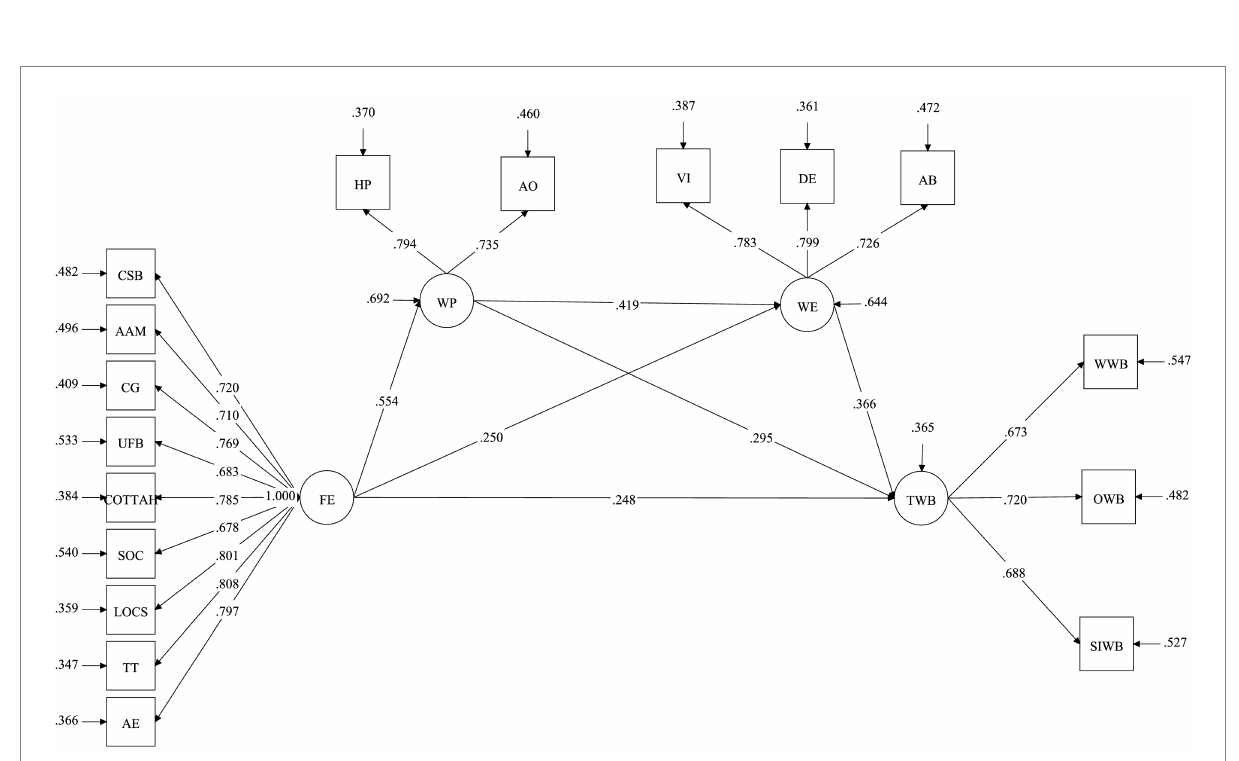
FIGURE 2 Structural equation model.